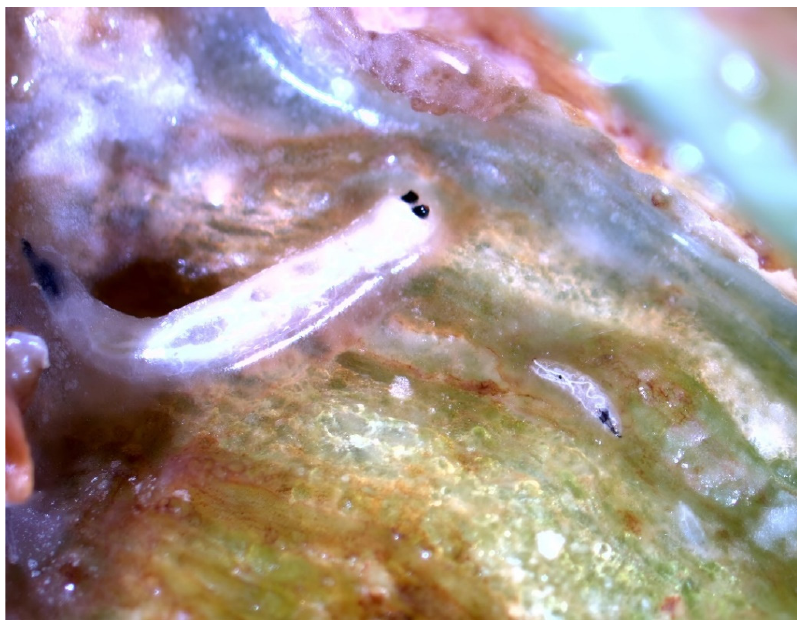
Figure 1. Atherigona orientalis specimen: second and third instar larvae on pepper fruit.